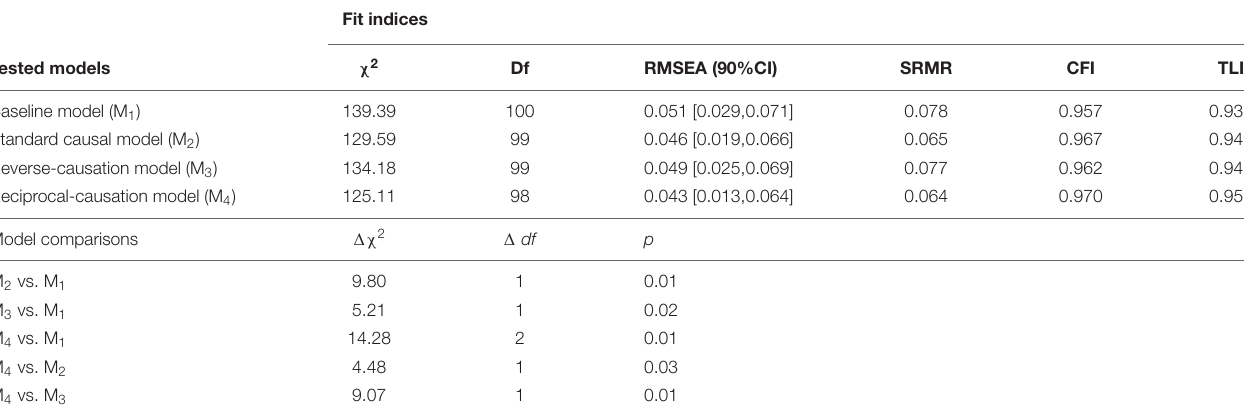
TABLE 3 | Fit indices and model comparisons among competing models to address the relationship between morphological awareness and reading comprehension. Fit